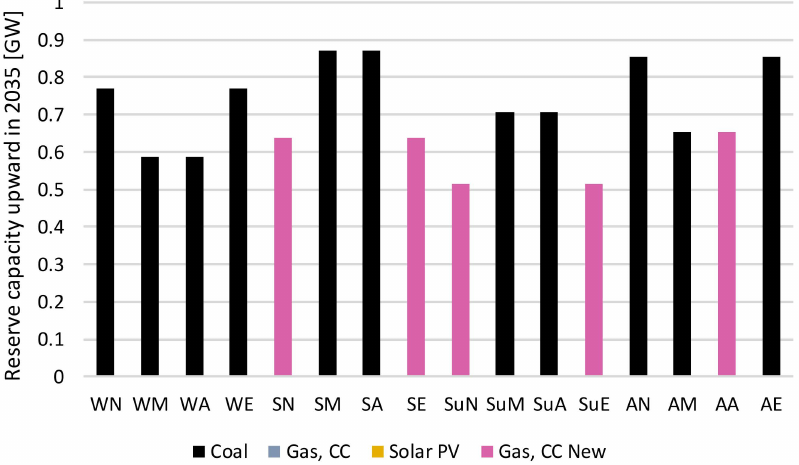
Figure 14. Reserve capacity supply (GW) per time slice in 2035 in the RETarget scenario—with code